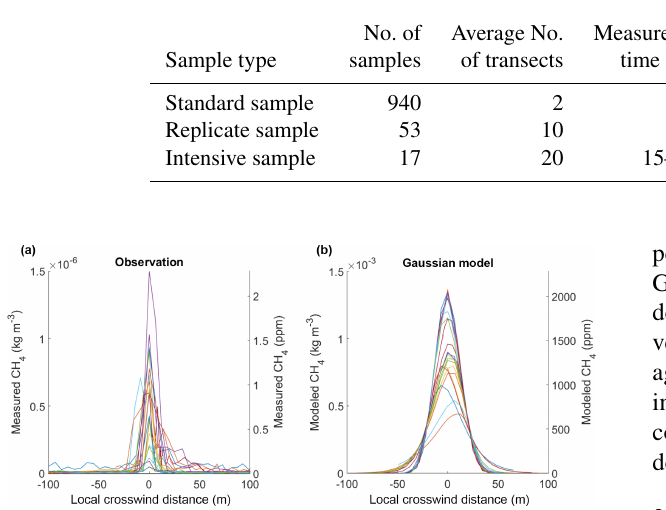
Figure 2. (a) Observations of CH 4 at a site showing multiple down- wind transects versus the local crosswind ( y ) distance. (b) Gaussian plume model outputs along the same downwind transects. Note that the scale difference between the panels is due to the inverse method- ology used where the model is set to a reference emission rate (of 1kgs − 1 )